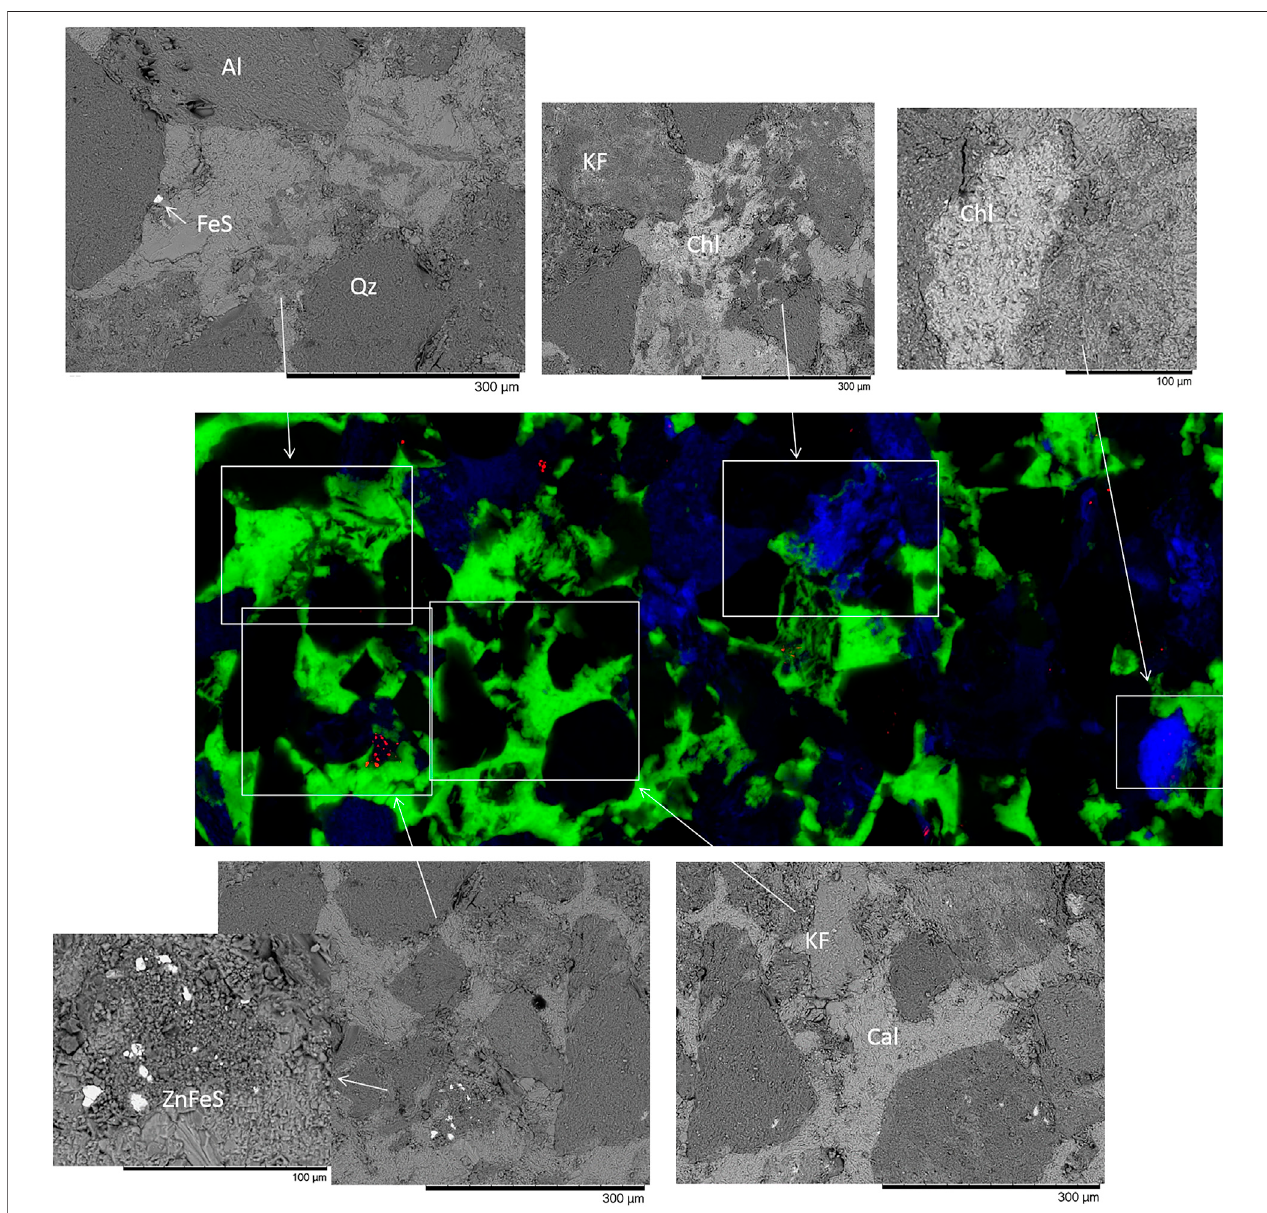
FIGURE 4 | XFM image of calcite cemented from 1056.03 m where red = Zn, green = Ca, and blue = Fe. The maximum concentrations shown are Zn = 6.54%, Ca = 91.8%, and Fe = 36.8%. Associated SEM images of mineral areas in white boxes are also shown. FeS, FeSx/pyrite cement + Cu. Qz, quartz; KF, K-feldspar; Chl, chlorite; Cal, calcite. ZnFeS, mixed sphalerite or ZnFe-sul fi de that also contained Ni.